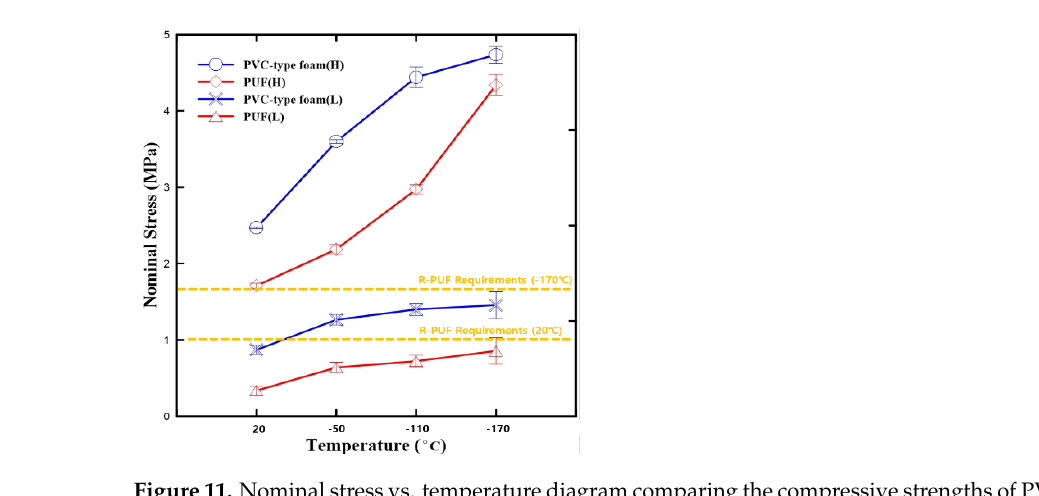
Figure 13. Stress – strain curve based on the results of the impact test. Figure 13 illustrates the force – displacement curve of the PUFs and PVC-type foams with different densities at various temperatures and impact energies. Between the elastic region and the early segment of the plateau region, a point exists where the curve gradu- ally linearly increases and then sharply decreases. This point is called the initial peak